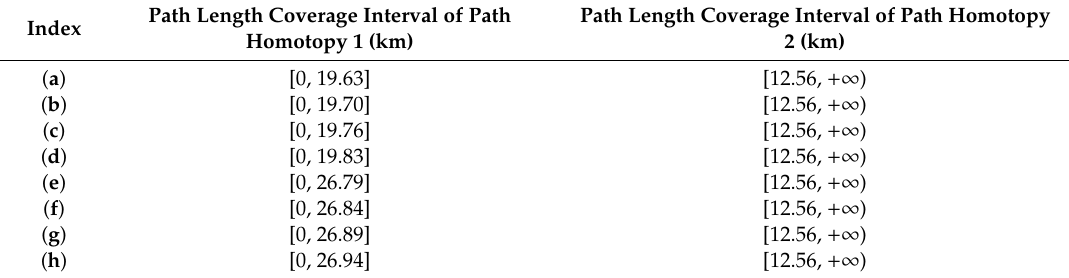
Table 2. Path length coverage interval.